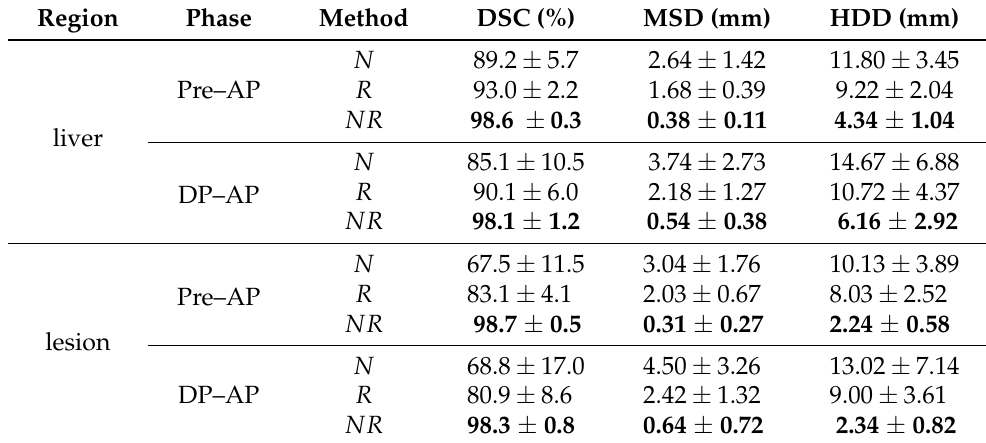
Table 4. Registration accuracy evaluated by DSC, MSD, and HDD (mean ± sd). The N refers to no registration, R to the rigid registration in the image preprocessing, and NR to the proposed nonlinear registration model with the volume preserving prior P ( u ) in Equation